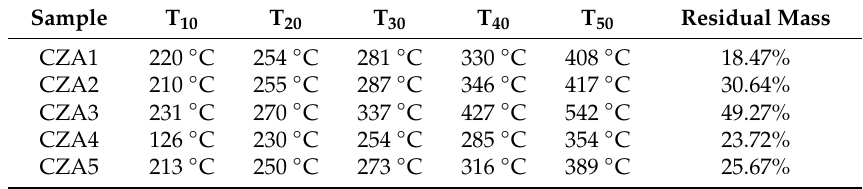
Figure 10. The TG-DSC curves for CZA1–CZA5. Table 5. Temperatures at which CZA1–CZA5 films lost 10%, 20%, 30%, 40%, or 50% of initial